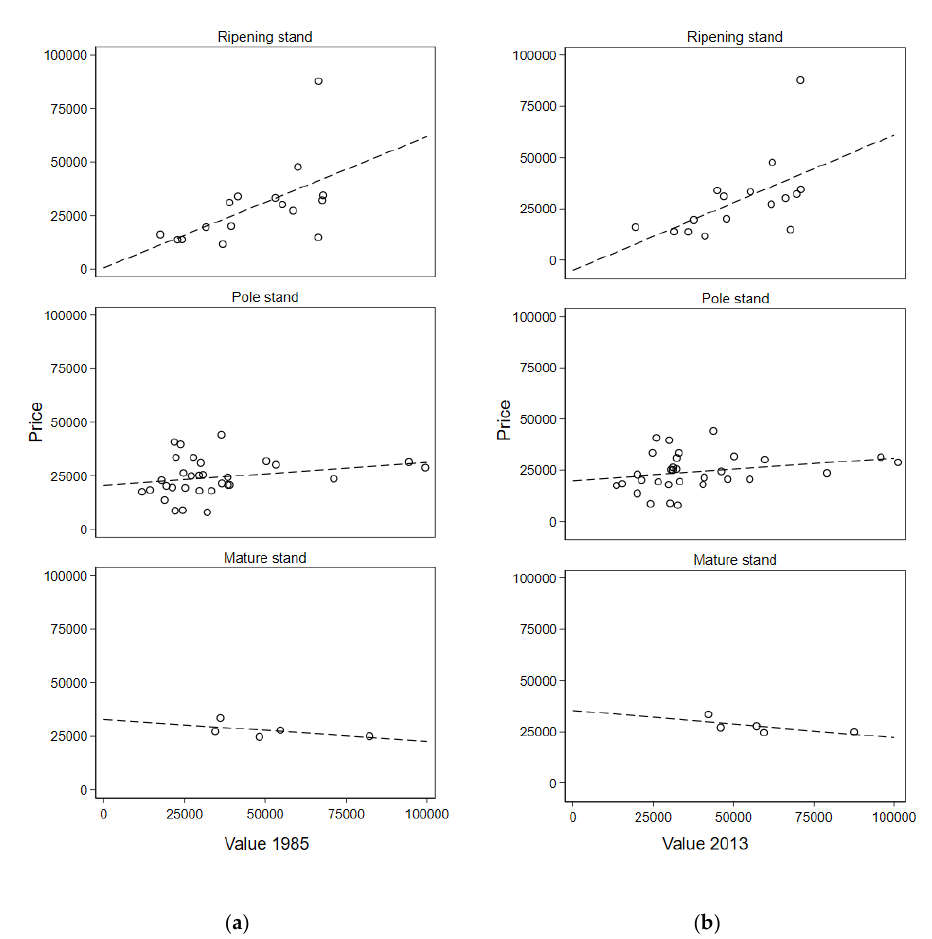
Figure A1. Correlation between sale prices and values by stand maturity ( a ) left panel results are based on 1985 valuation tables. ( b ) right panel results are based 2013 valuation tables.